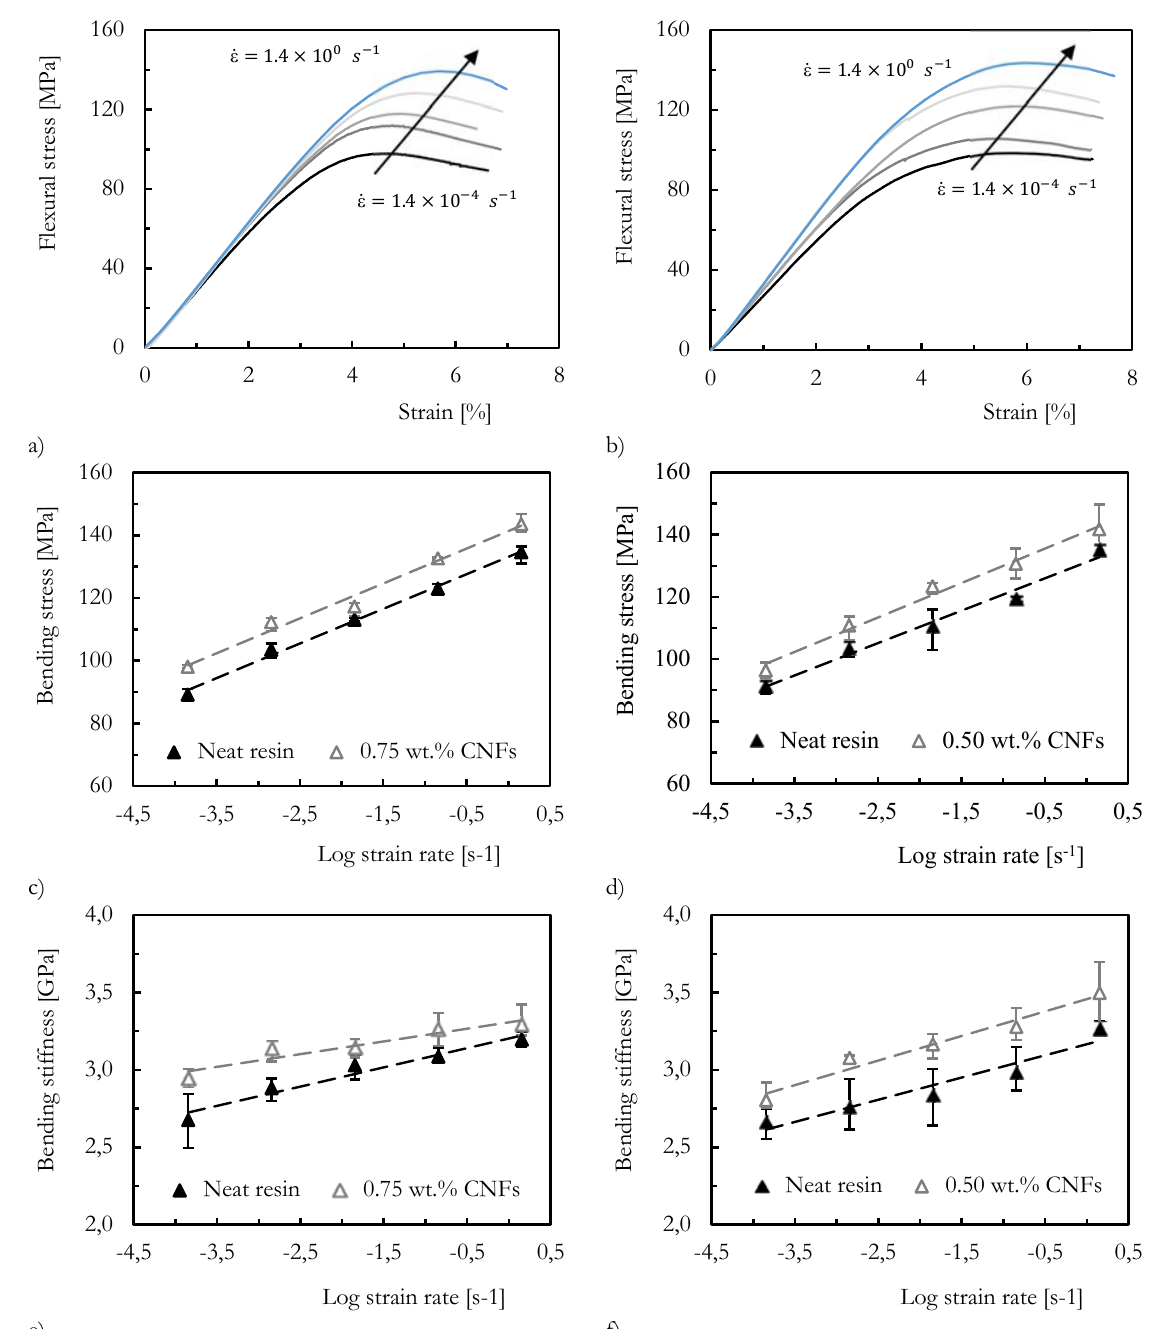
Figure 6: Effect of the strain-rate: (a) For resin Sicomin SR 8100 with 0.75 wt.% CNFs; (b) For resin Ebalta AH 150 with 0.5 wt.% CNFs;(c) Bending stress Sicomin; (d) Bending stress Ebalta; (e) Bending stiffness Sicomin; (f) Bending stiffness Ebalta; (g) Bending strain Sicomin; (h) Bending strain